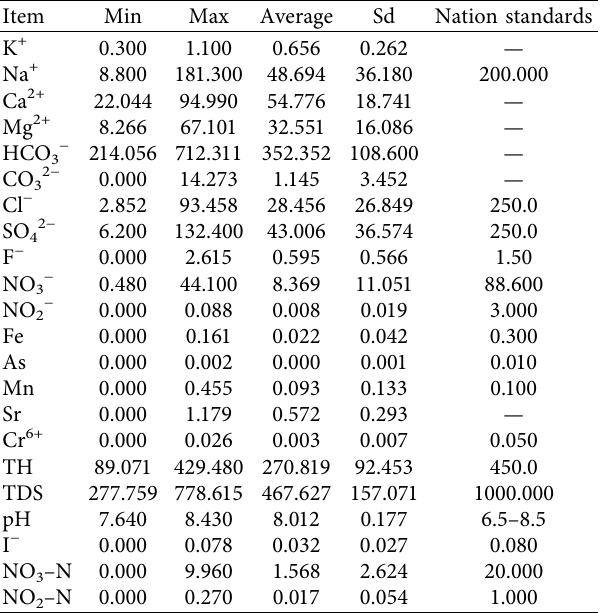
Table 1: Descriptive statistics of concentrations of groundwater parameters.